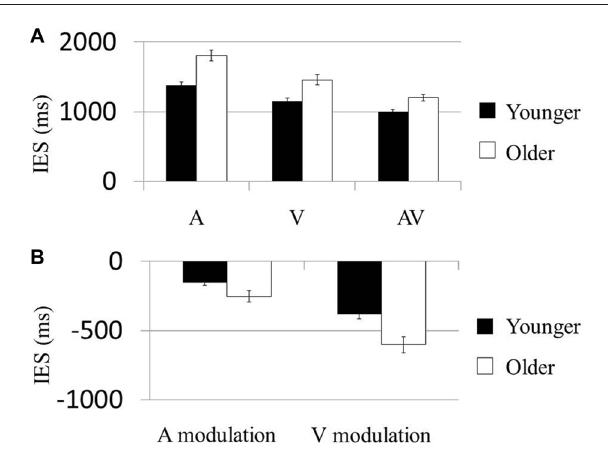
FIGURE 2 | AV stimuli were more beneficial in older participants. (A) Mean inverse efficiency score (IES) in three conditions (A, V and AV) for younger and older participants. Younger participants performed better than the older participants in each condition. (B) “Modulation” scores were computed as the difference in IES between multisensory (AV) and unisensory (either A or V) conditions, allowing us to examine the degree by which AV information could improve performance in each subject. Participants who showed much greater behavioral improvements in the AV condition than in unisensory conditions were related to more negative benefit scores. The older group showed more negative A modulation and V modulation scores than the younger group. Error bars represent standard